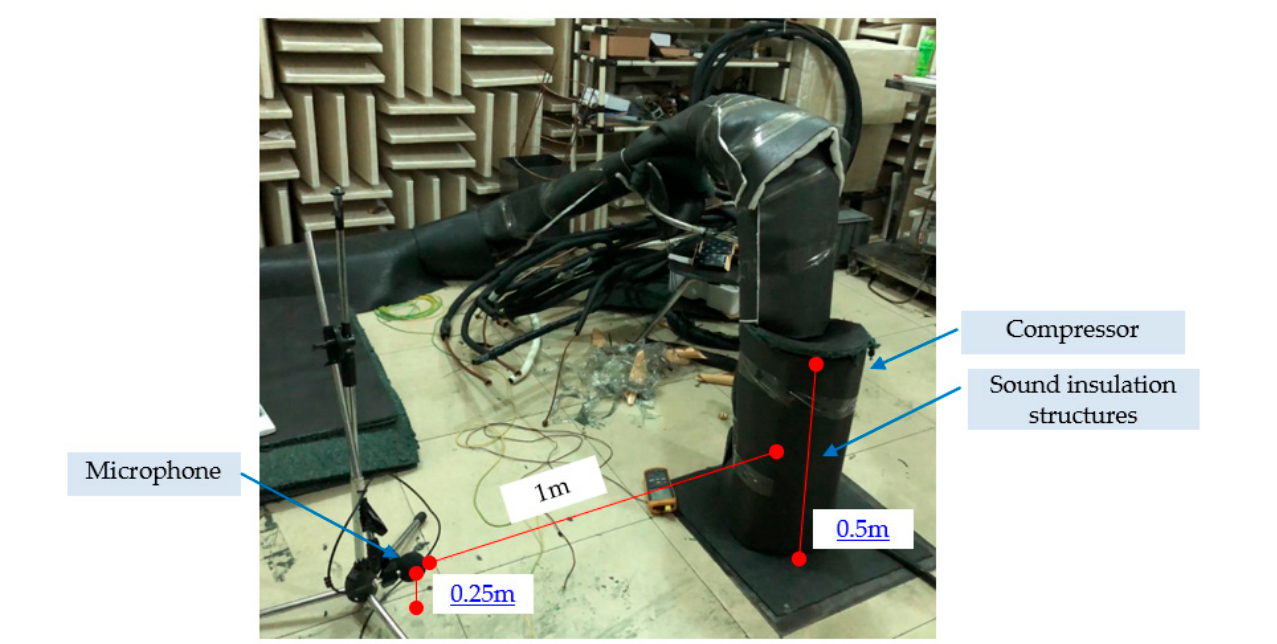
Figure 2. Schematic diagram of the sound insulation test for the sound insulation structure.